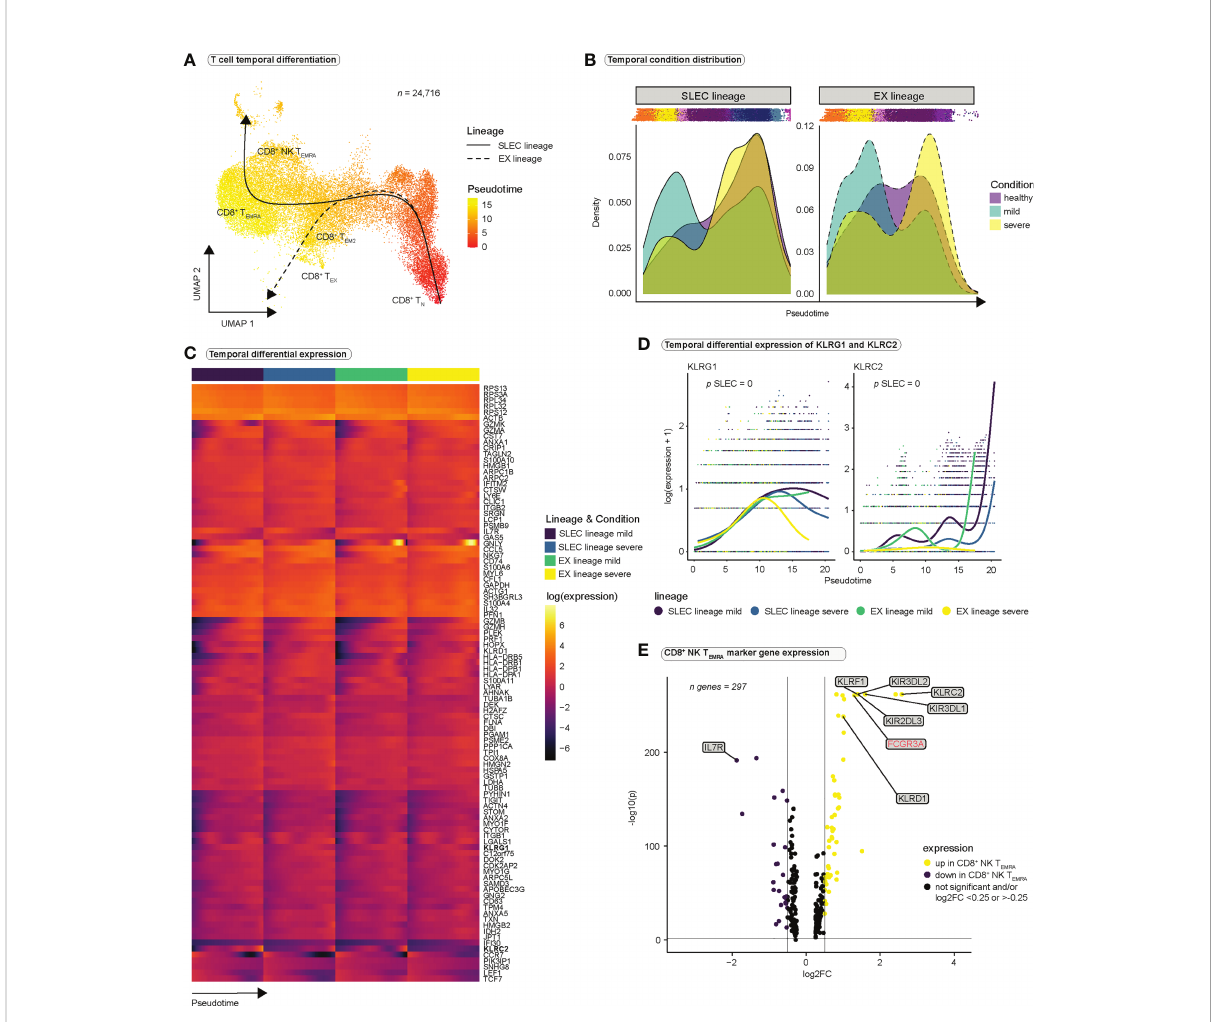
FIGURE 3 CD8 + T cells differentiate towards an NK-like phenotype during SARS-CoV-2 infection. (A) Pseudotimes and estimated trajectories projected onto the integrated UMAP of cell types likely originating in naïve CD8 + T cells ( n = 24,716). For trajectory inference with Slingshot, naïve CD8 + T cells were manually chosen as the origin of differentiation. (B) Temporal distribution of cell densities for all three conditions across pseudotime. Shifts in distribution between the mild and the severe condition for the short-lived effector cells (SLEC) and exhaustion (EX) lineage were tested with the Kolmogorov-Smirnov method (EX: D = 0.40237, p < 2.2e-16, SLEC: D = 0.31004, p < 2.2e-16). (C) Heatmap depicts differentially expressed genes between the progenitor and differentiated cell populations across pseudotime (start vs. end testing). (D) Smoothed expression of KLRG1 and KLRC2 across pseudotime with the y-axis on natural logarithmic scale. p -values report the result of differential expression analysis between progenitor and differentiated cell states across pseudotime (start vs. end testing). An extended panel of genes and their UMAP projections are reported in Figure S4. (E) Volcano plot of genes differentially expressed in CD8 + NK-like T EMRA